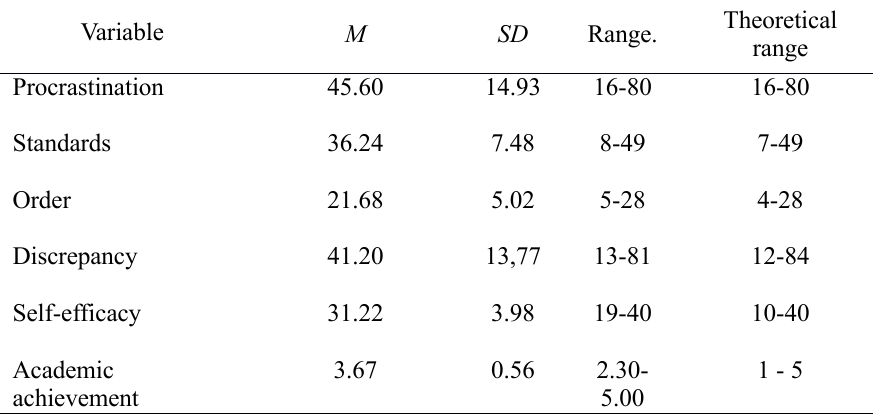
Table 1. Descriptive data for measured variables